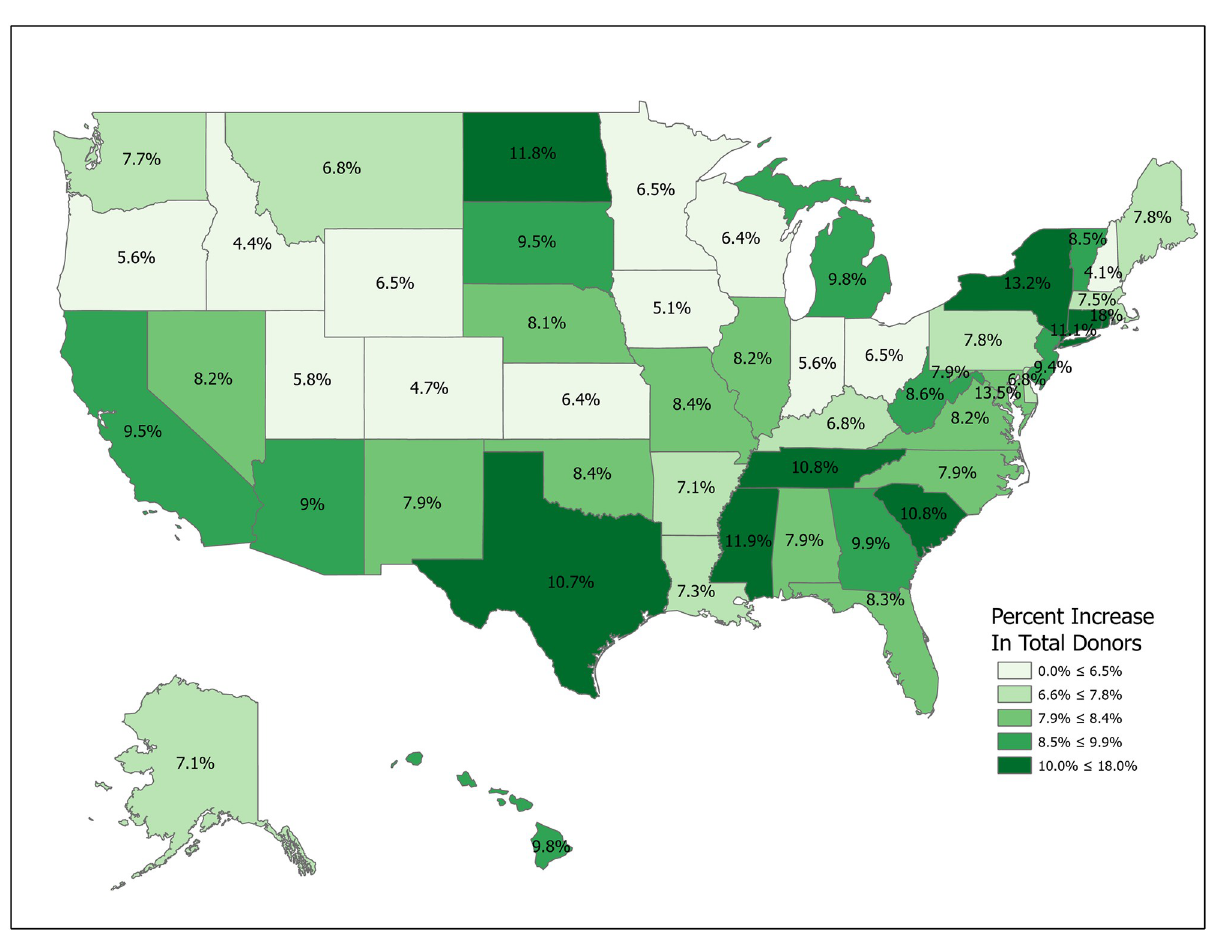
Fig 13. Simulation 7: Increase non-registered donor authorization rate ( q 2 ) by 5 percentage points. Data come from Table 6. Maps created by ArcGIS Pro, URL: https://www.esri.com/en-us/arcgis/products/arcgis-pro/overview. Base Map: World Light Gray Base, URL: https://services.